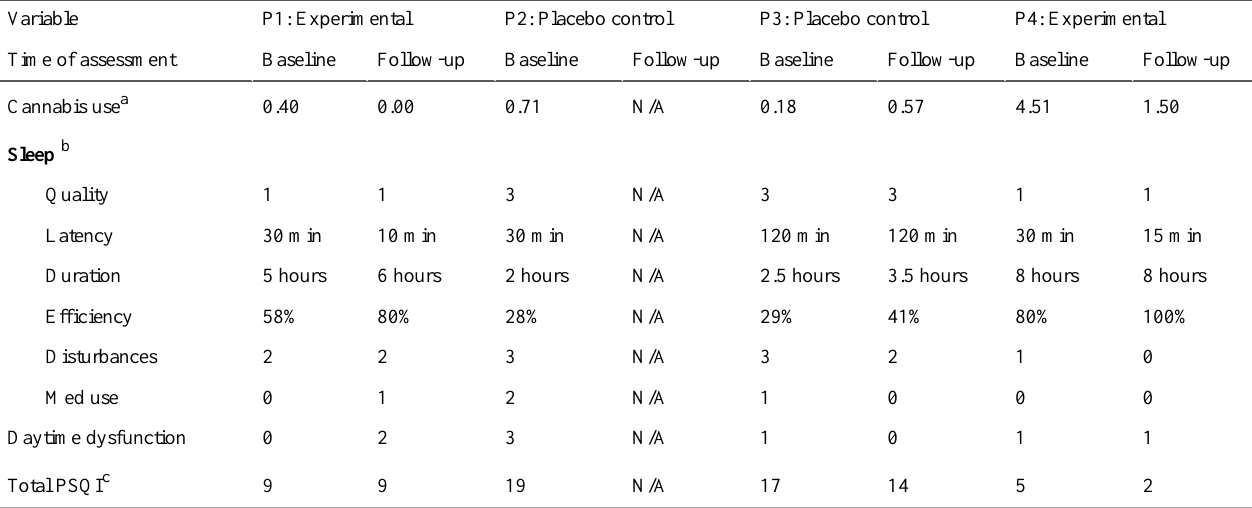
Table 1. Participant-level cannabis use and sleep data for baseline and follow-up